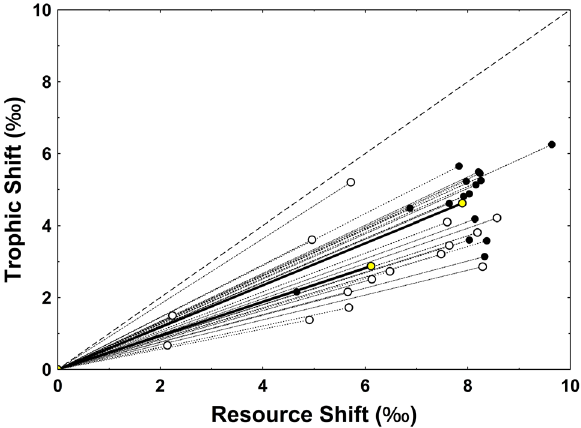
Figure 4. Net displacement of brown trout in isotopic (δ 13 C, δ 15 N) space as a result of moving from freshwater to marine feeding. Black and white dots, respectively, plot the individual isotope signatures of marine-captured trout from Rivière du Nord and Golfe des Baleiniers sample sites. Lines connecting each point to the origin define the magnitude (Euclidean distance) and angle of the shift. All lines fell below the 45° line (large dashes), indicating that trophic niche shifts were dominated by greater changes in δ 13 C than δ 15 N. Yellow dots and associated heavy solid lines plot the means and mean change vectors for the Rivière du Nord (upper dot) and Golfe des Baleiniers (lower dot) sample sites. The angular change, measured as the counter-clockwise angle from the resource shift axis, was significantly greater for the Rivière du Nord than the Golfe des Baleiniers sampled fish.